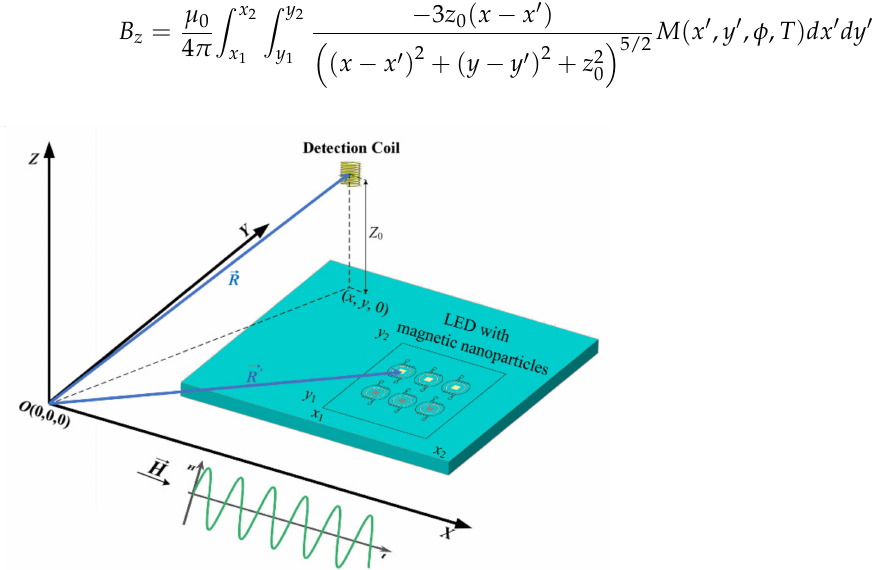
→ H , perpendicular to the sensitive